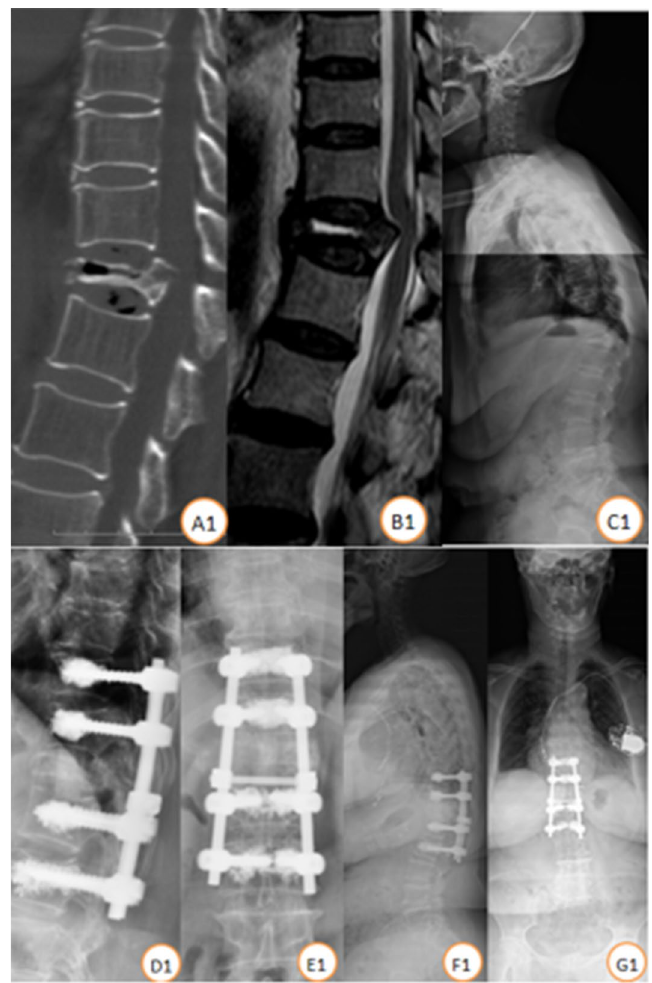
Figure 4. Case illustration of a patient. Female, 80 years, BMD (T score) was − 3.4SD. ( A1–C1 ) Preoperative lateral X-ray and CT scan showed T12 vertebral fracture with, MRI showed low signal of the necrotic area on T2-weighted images. Follow-up standing X-ray at 2 year ( D1,E1 ) and 5 year ( F1,G1 ) post T10-L2 bone cement- augmented pedicle screw fixation.